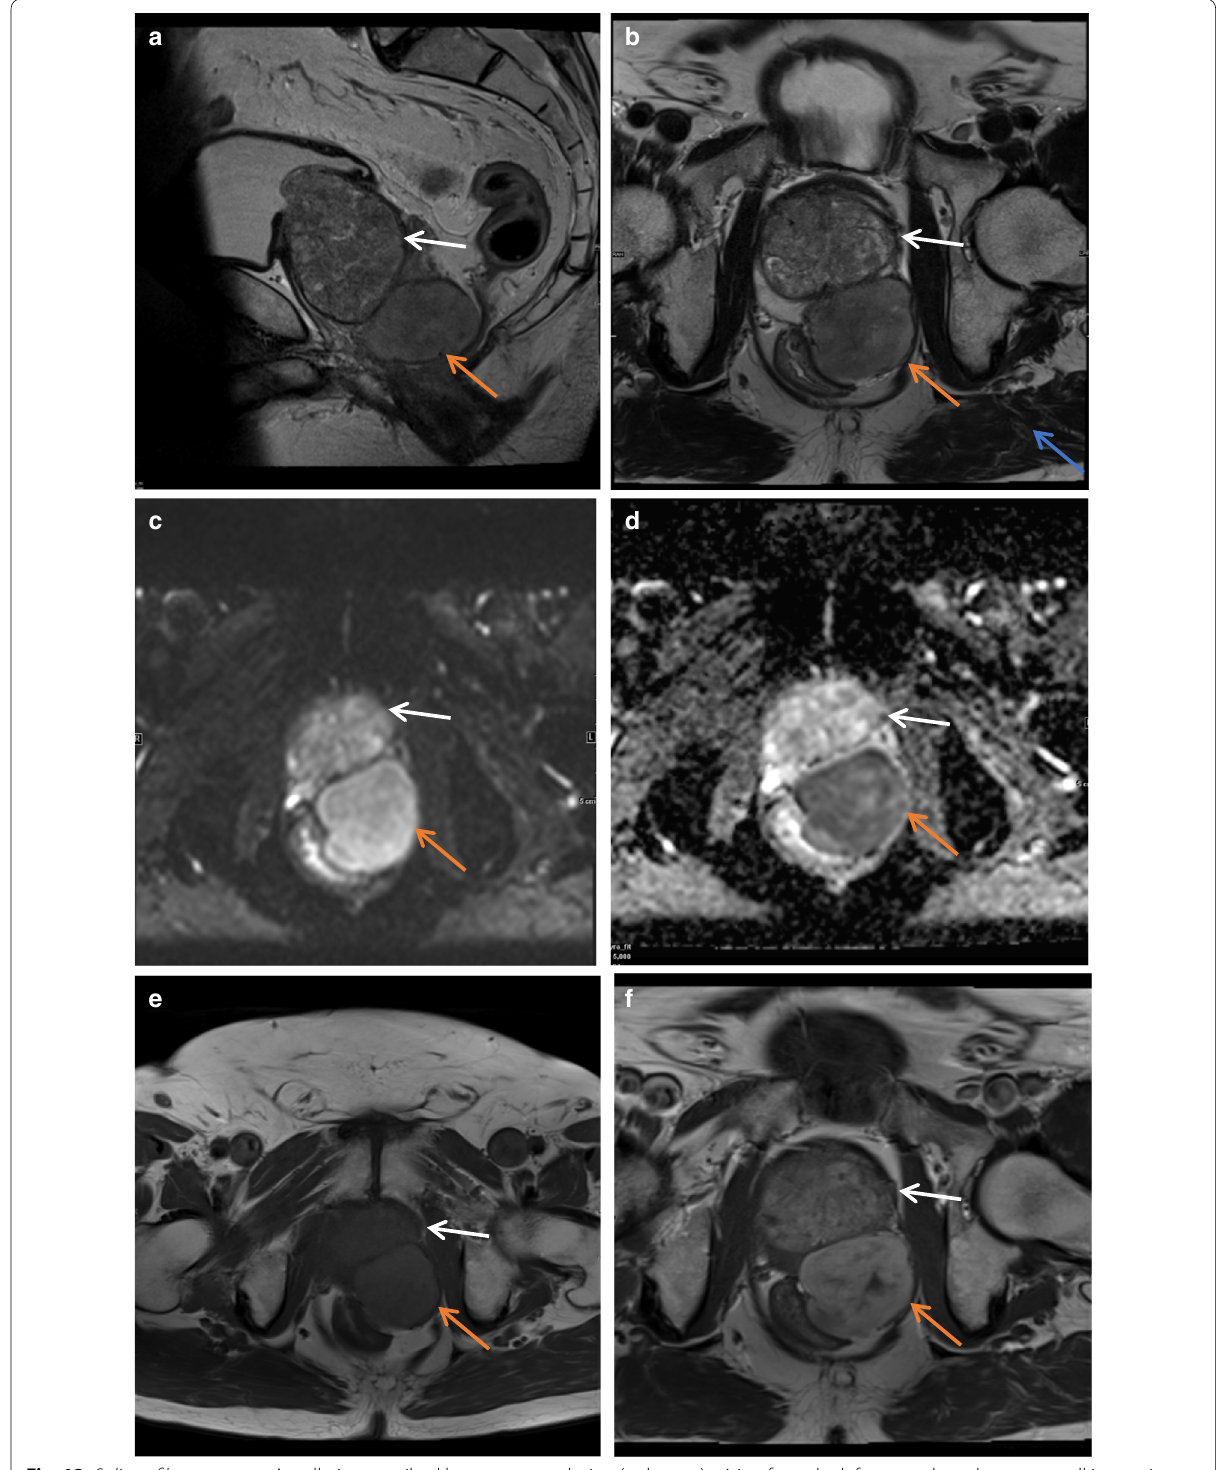
Fig. 12 Solitary fibrous tumour A well-circumscribed homogeneous lesion (red arrow) arising from the left posterolateral prostate wall is seen in ( a ) sagittal and ( b ) axial T2W images as isointense to prostate (white arrow) and hyperintense to gluteus muscle (blue arrow). c DWI and ( d ) ADC images demonstrate diffusion restriction in the lesion. In e and f the lesion is iso- to mildly T1 hyperintense to prostate and shows uniform contrast enhancement. This was biopsy-proven solitary fibrous